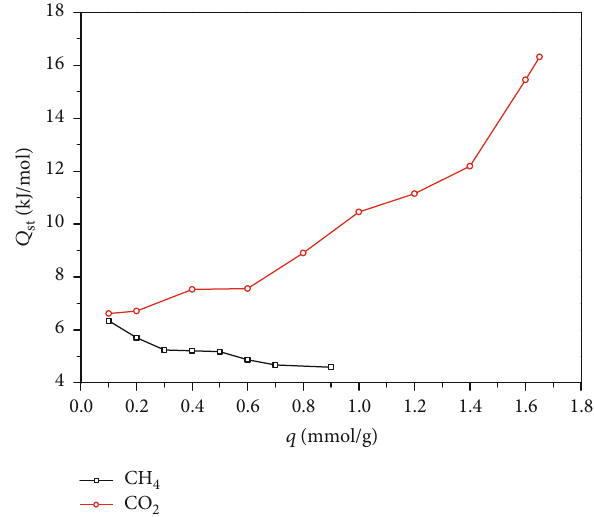
Figure 10: Isosteric heat of adsorption of CO